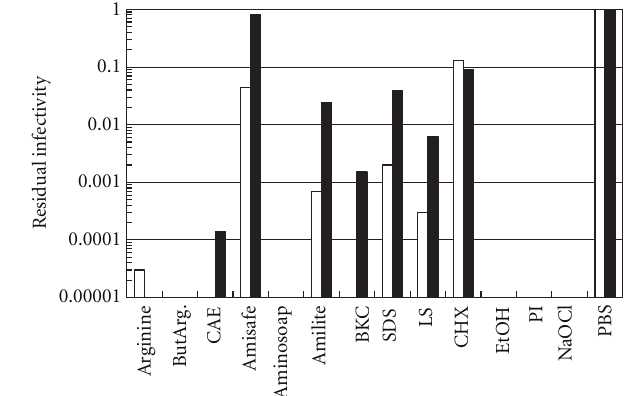
Figure 1: Inactivation of HSV-1. The virus was incubated in the solution indicated below for 5min at 30 ◦ C. Number of infectious virus was determined by a plaque assay on Vero cells after the incubation and was normalized to that incubated in PBS. Arginine (0.5M at pH 4.0 in 10mM citrate), ButArg (0.5 M in pH 4.0 in 10mM citrate), CAE (0.2% in 5mM citrate and 0.15 M NaCl at pH 4.8), Amisafe (0.2% in 5mM citrate and 0.15 M NaCl at pH 4.8), Aminosoap (0.2% in 5 mM citrate at pH 7.0), Amilite (0.2%